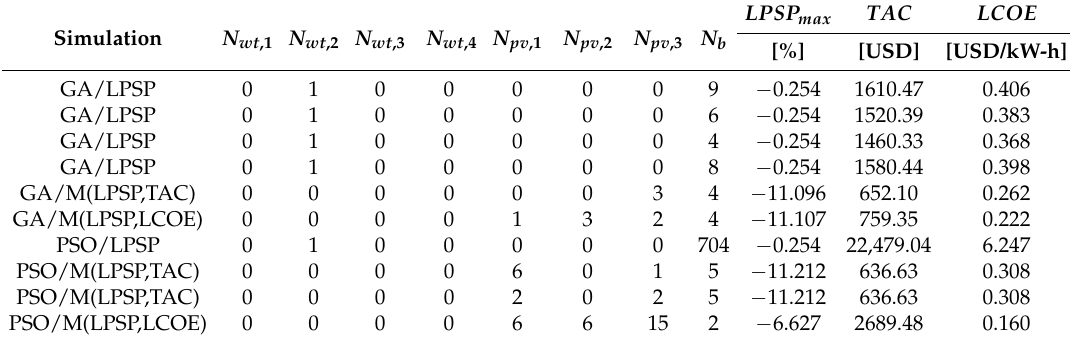
Table 8. Best results for Case II: demand of non-interconnected zone with water